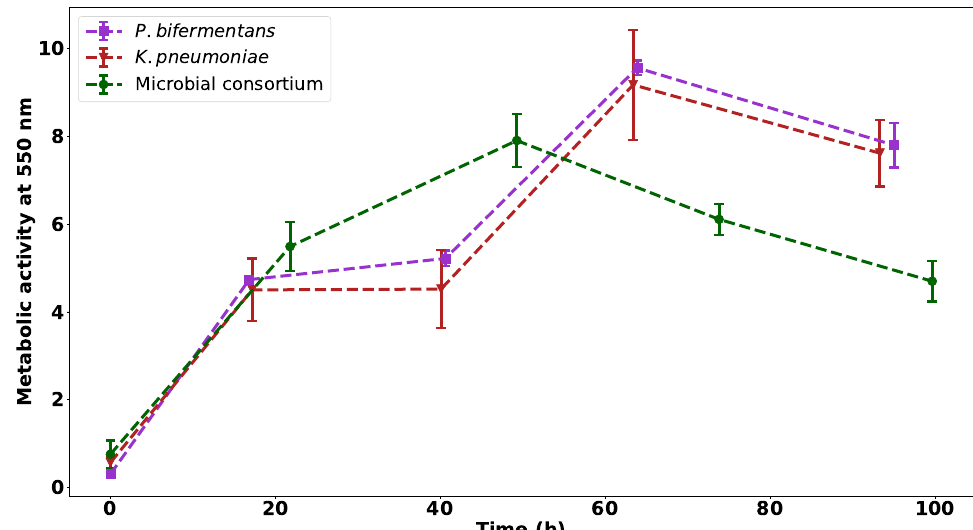
Figure 2. The metabolic activity of the pure cultures and the microbial consortium observed over 100 h, with n =